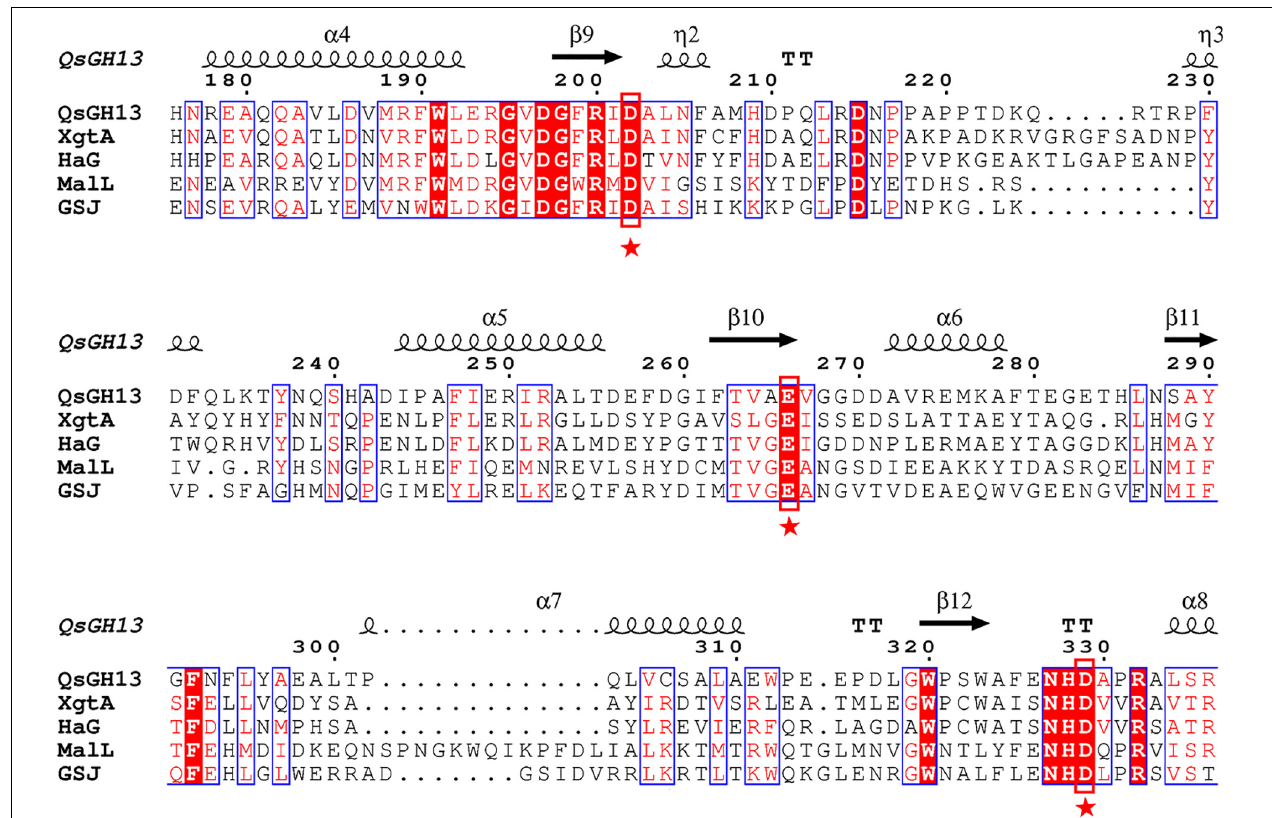
FIGURE 4 | Multiple sequence alignment of QsGH13 and other members of the GH13 family. The sequences include alpha-glucosyl transfer enzyme XgtA from Xanthomonas campestris (PDB ID:6AAV), alpha-glucosidase HaG from Halomonas sp. H11 (PDB ID:3WY1), oligo-1,6-glucosidase MaIL from Bacillus subtilis subsp. subtilis (PDB ID:4M56), and alpha-glucosidase GSJ from Geobacillus sp. HTA-462 (PDB ID: 2ZE0). The conserved catalytic residues in the GH13 family were marked with a red box. The asterisk represents the catalytic